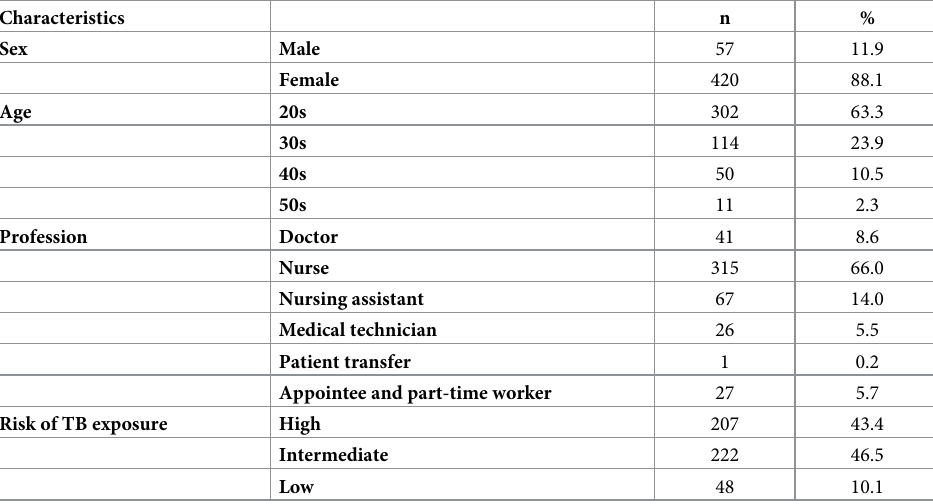
Table 2. Characteristics of healthcare workers with follow-up QFT-GIT results (n = 477).